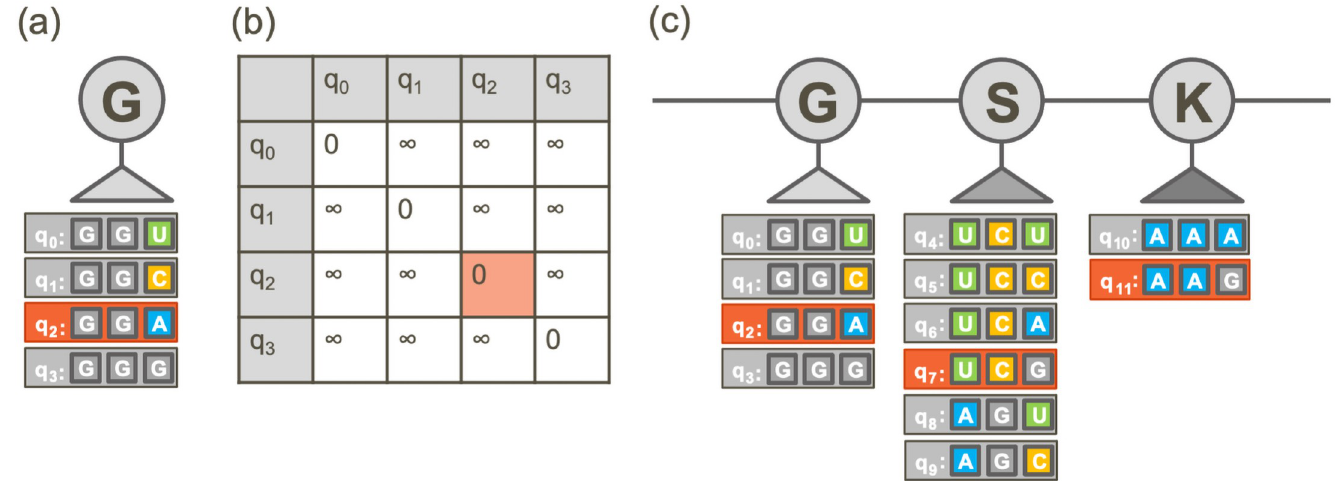
Fig 1. (a) Example mapping of each possible codon for the amino acid Glycine (gray oval labeled “G”) to qubits. Gray boxes represent qubits labeled q 0 ... q 3 , and the codon assigned to each qubit is shown next to the qubit label. (b) A penalty matrix is constructed to add infinite energy to cases where more than one codon is in the “1” state. In this example, qubit q 2 is in the “1” state and the rest are in the “0” state, which returns an energetic penalty equal to 0. (c) Example mapping of codons for protein sequence GSK ... to qubits. One codon is selected for each position in the sequence, highlighted in